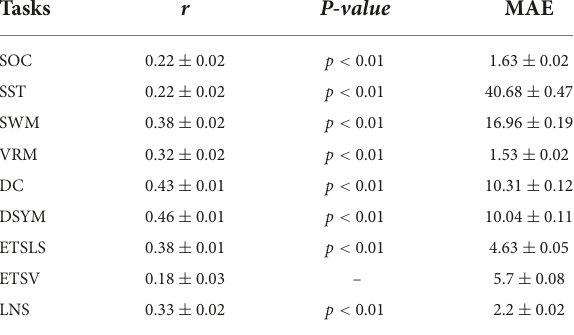
TABLE 2 Performance of gray matter